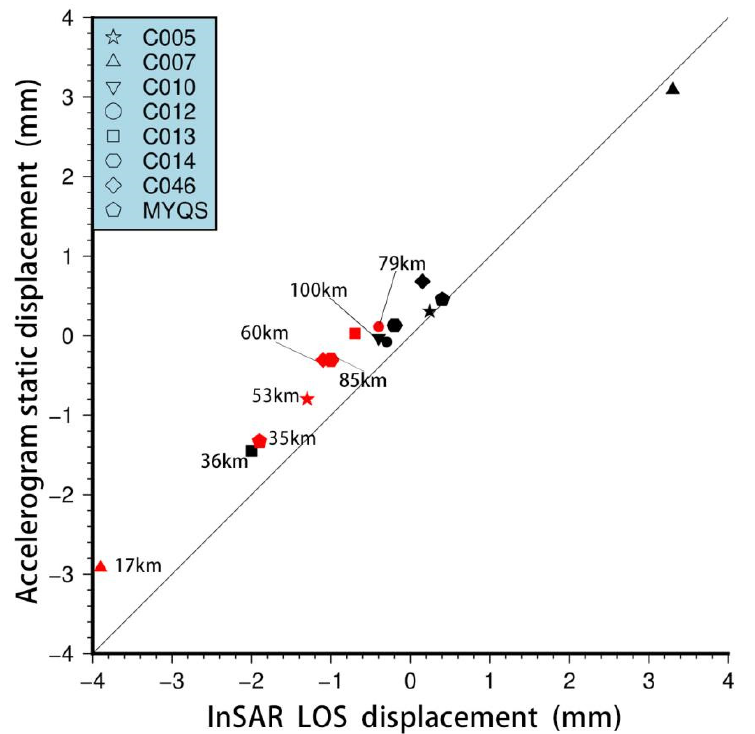
Figure 4. Comparison of static displacement between InSAR and accelerogram data projected in the line-of-sight (LOS) direction. The red shows the observation from InSAR ascending track and the black demonstrate the observation from InSAR descending track. The numbers in the figure correspond to the distance from each station to the epicenter.